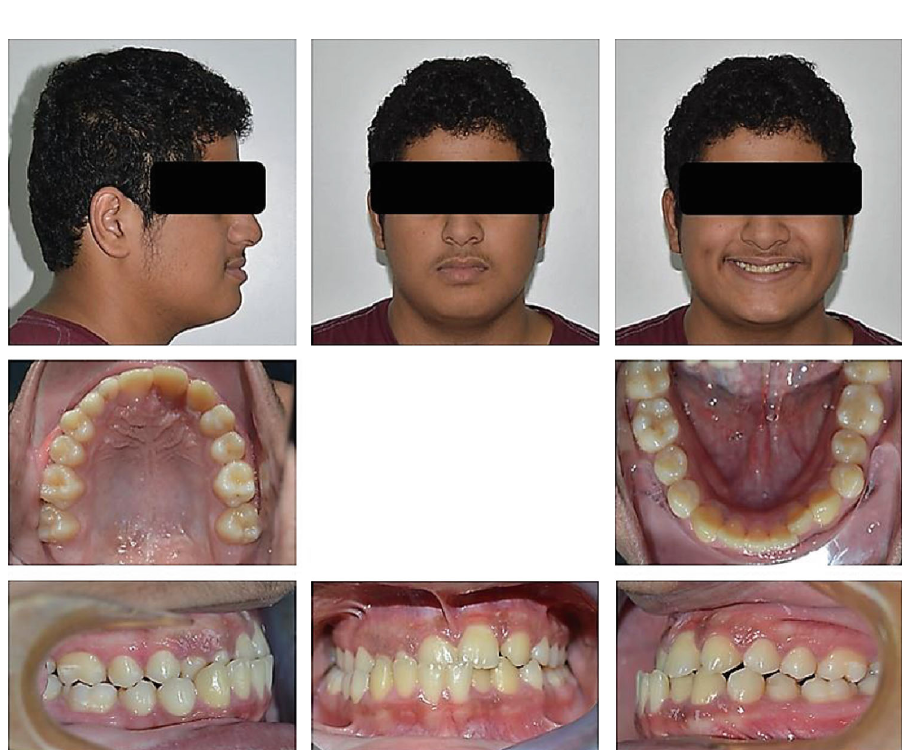
Figure 1: Pretreatment extraoral and intraoral photographs of the